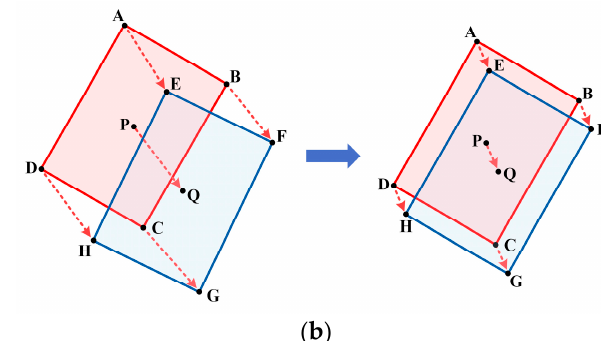
Figure 9. The schematic diagram of the TDIoU loss. ( a ) The computation of ℛ TDIoU . The red and blue boxes indicate the predicted box B pb and the ground truth B gt , respectively. The red and blue lines denote the distance between sampling points; ( b ) the process of bounding box regression guided by TDIoU loss. After back-propagation, the model tends to pull the centroids and vertices of the anchor/proposal toward the corresponding points of the ground truth until they overlap.